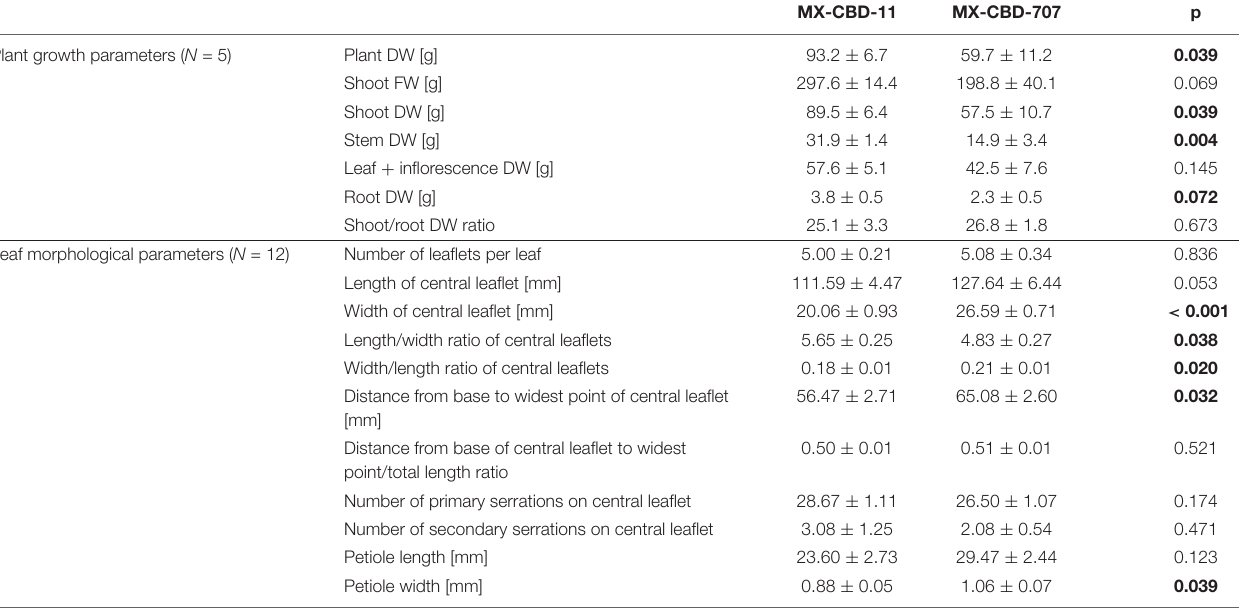
TABLE 1 | Growth and morphological parameters of two breeding populations of medical cannabis, namely MX-CBD-11 and MX-CBD-707.